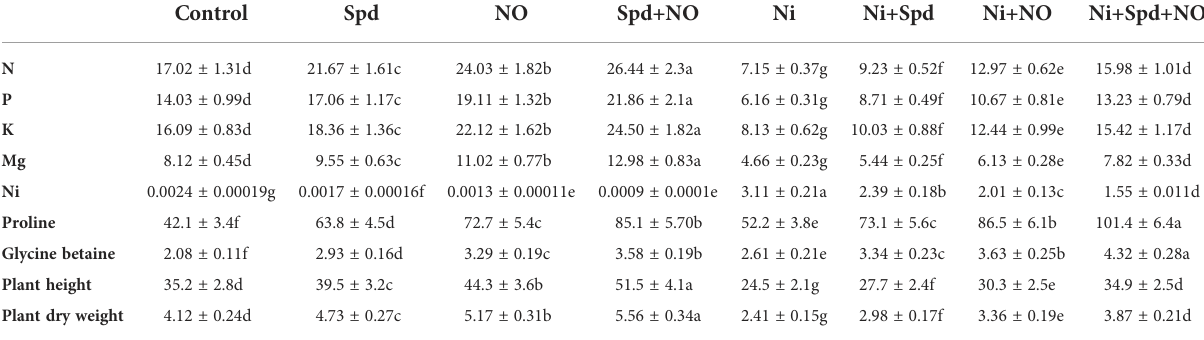
TABLE 1 Effect of nitric oxide (NO; 50 µM) and spermidine (Spd; 100 µM) supplementation on nitrogen (N), phosphorous (P), potassium (K), magnesium (Mg), nickel (Ni), proline, glycine betaine, plant height, and plant dry weight in Solanum lycopersicum L. treated with nickel